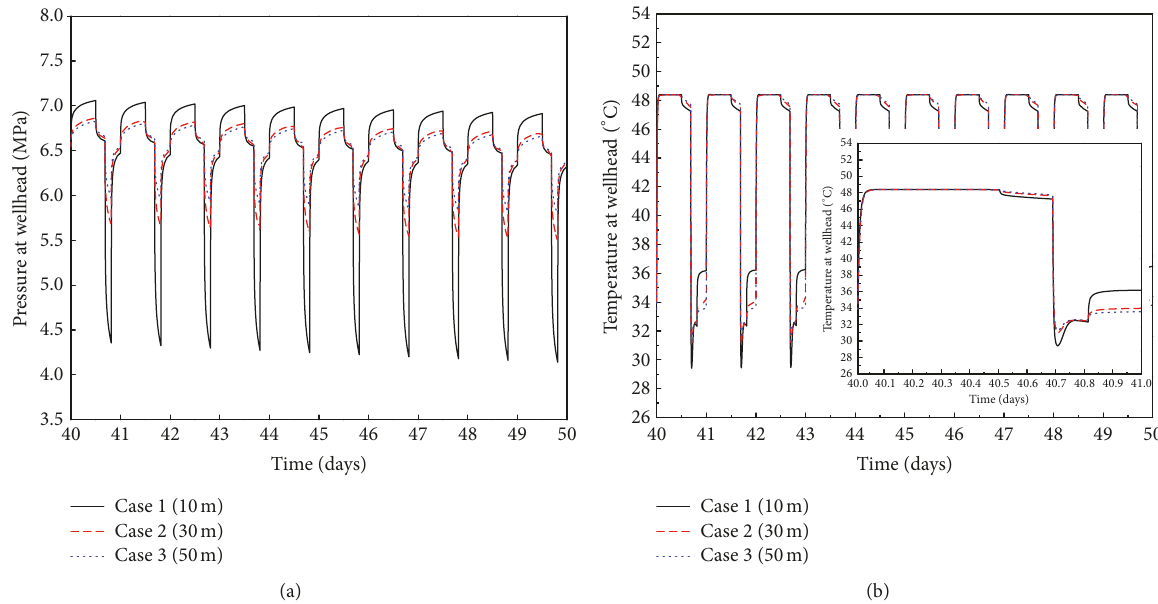
Figure 6: Comparisons of the variances of pressure and temperature at the wellhead during the cycle processes among the three different well penetrating cases. (a) Pressure. (b)